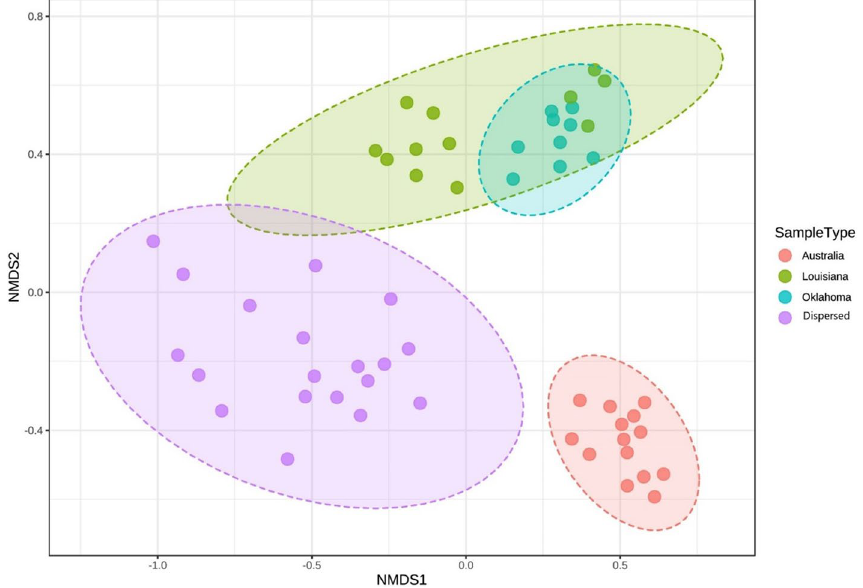
Figure 3. Non-metric multidimensional scaling (NMDS) plots depicting the distribution of endometrial lavage samples based on their microbial composition (beta diversity). The samples are color coded based on their geographical origin. NMDS1 and NMDS2 values were calculated based on the Bray–Curtis Index 23 .